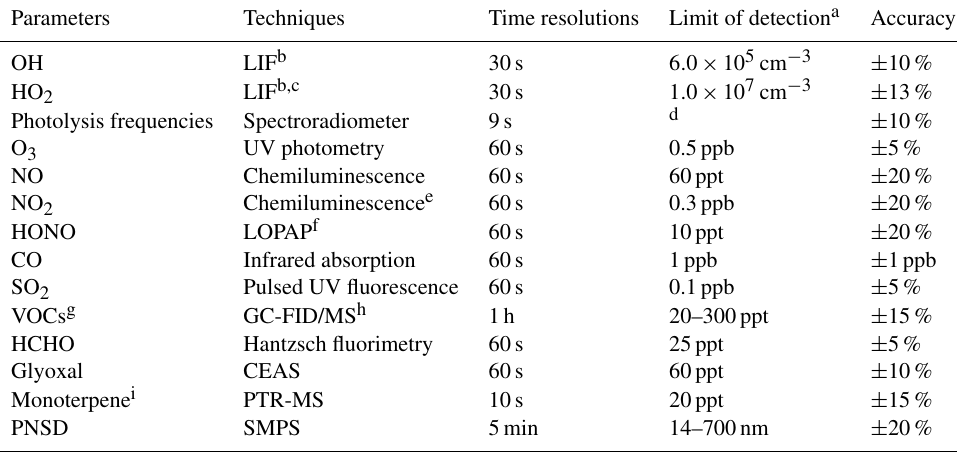
Table 1. Measured species and performance of the instruments.